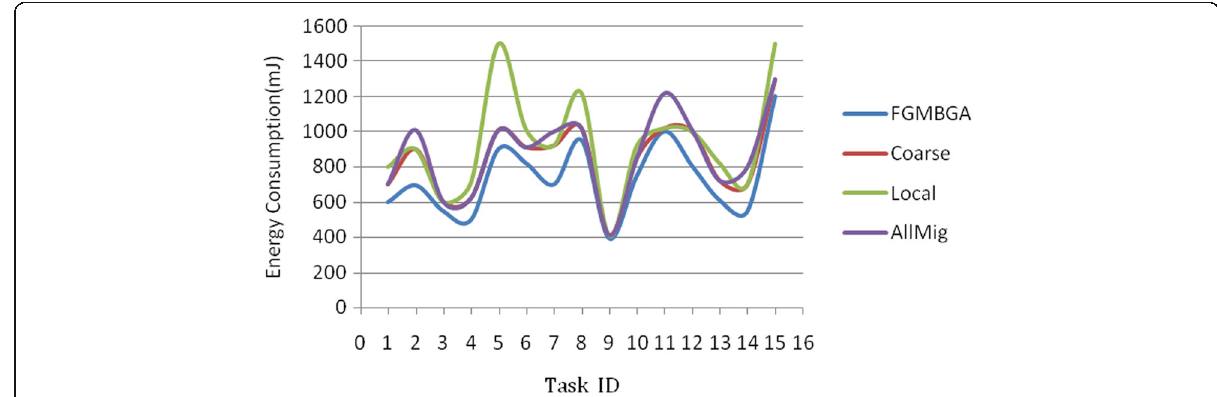
Fig. 5 Comparison of task energy consumption under four strategies. It can be observed that the results of the coarse-grained task migration strategy are always the same as the results of the local execution strategy or the total uninstallation to the MEC server strategy, because it is based on the entire mobile terminal application as an object for index measurement